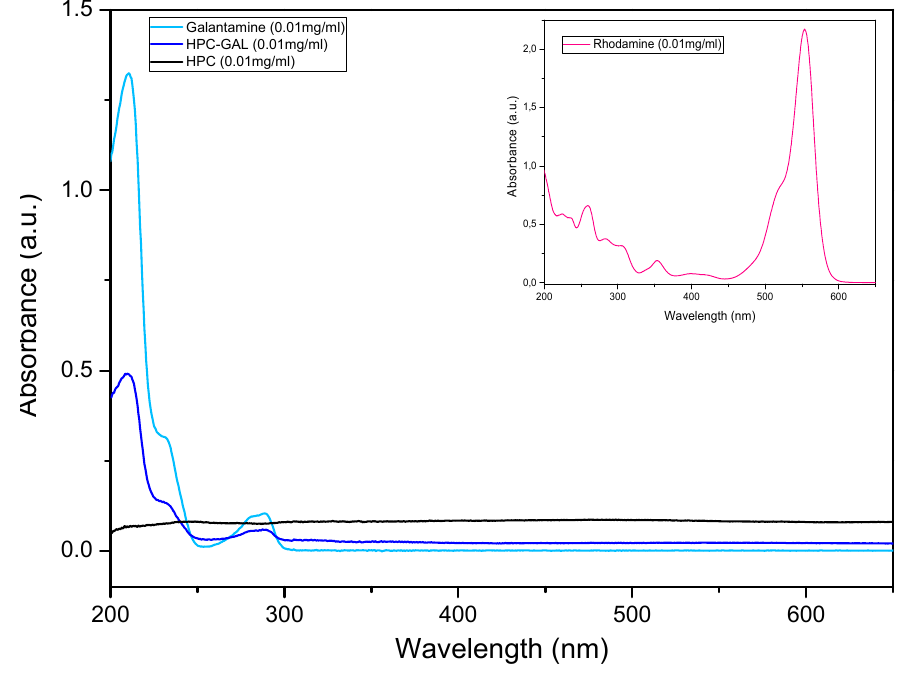
Figure 13. UV–Vis absorption spectra for water solutions of Rhodamine, galantamine, HPC and HPC–